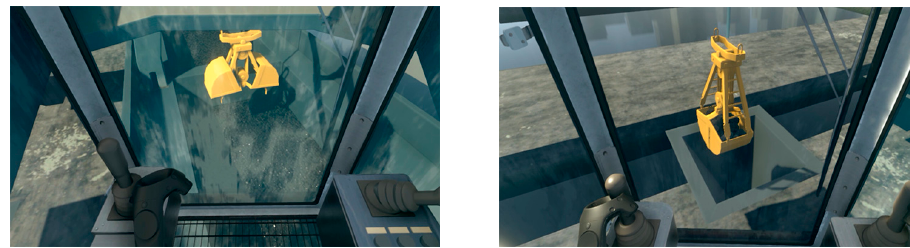
Figure 5. Crane simulator with main functionalities on steering the crane’s tower and grab.